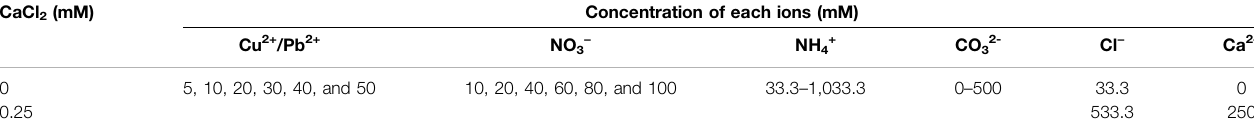
TABLE 2 | Summary of the numerical simulations. CaCl 2